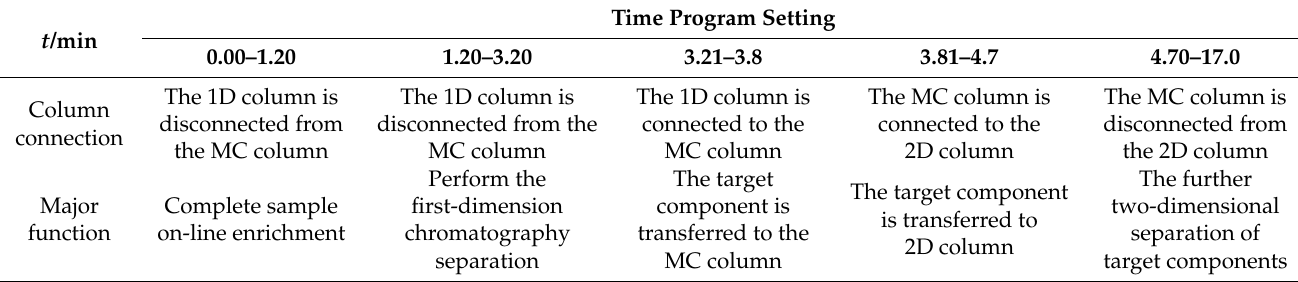
Table 1. Table 1. Time program for 2D-LC detection of three